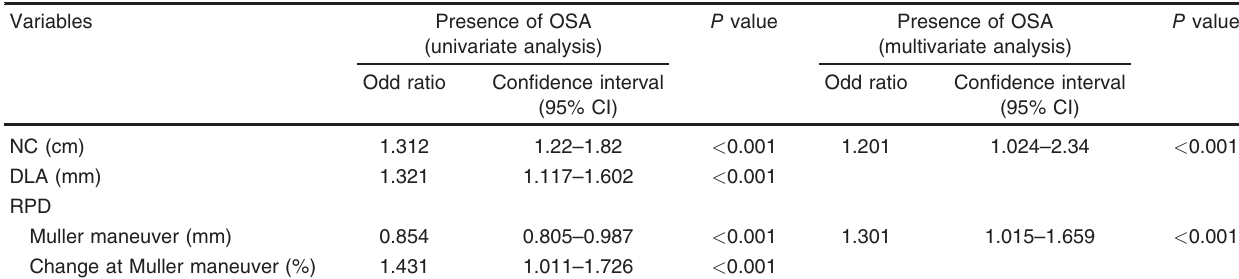
Change at Muller maneuver (%) 1.431 1.011 – 1.726 < 0.001 AHI, apnea – hypopnea index; CI, confidence interval; DLA, distance between lingual arteries; NC, neck circumference; OSA, obstructive sleep apnea; RPD, retropalatal